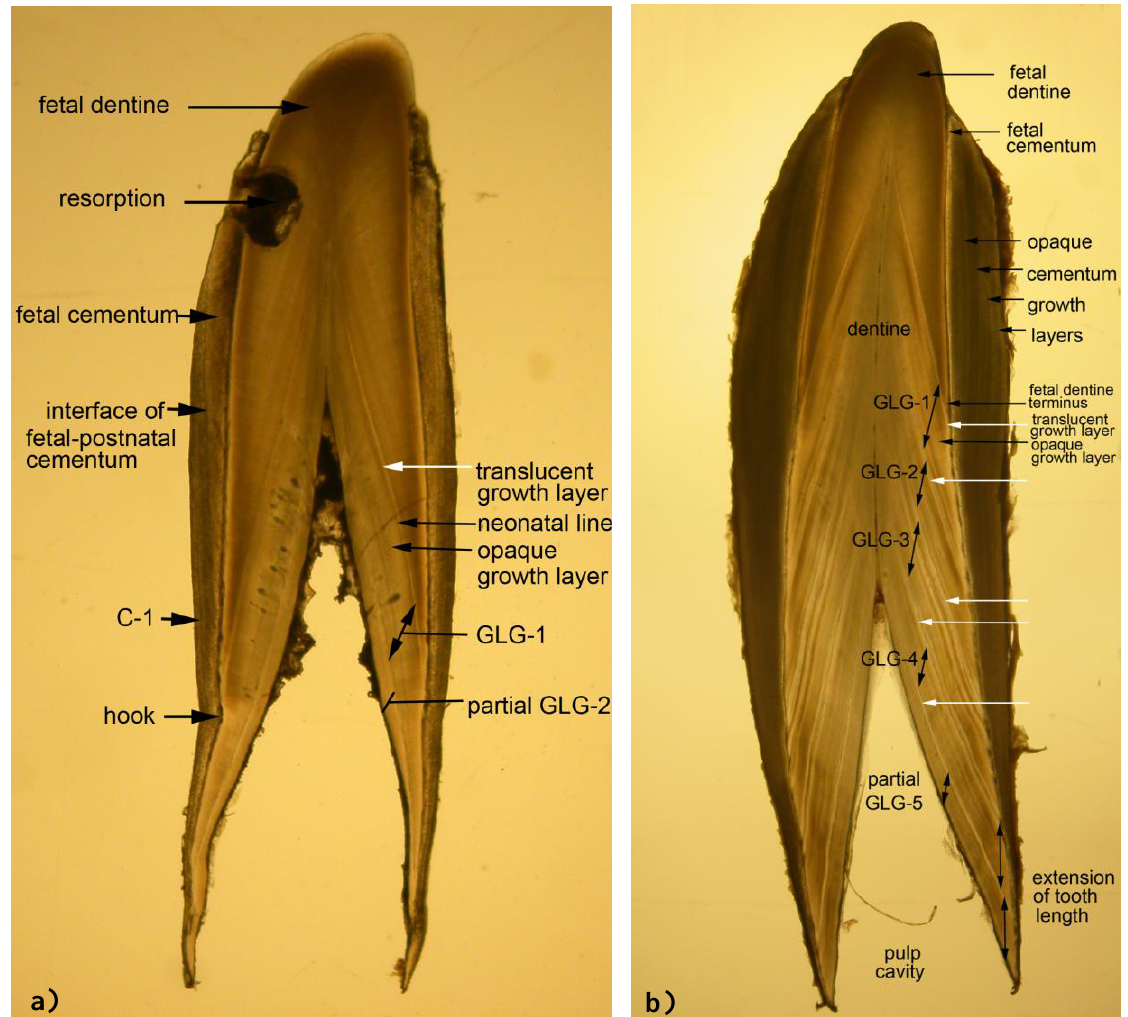
Fig. 9. The last-formed growth layer adjacent to the pulp cavity is opaque. In (a) B95-545, MNR-5, it is < ½ the preceding opaque growth layer both in width and length (seen in the extension at the dentine-cementum